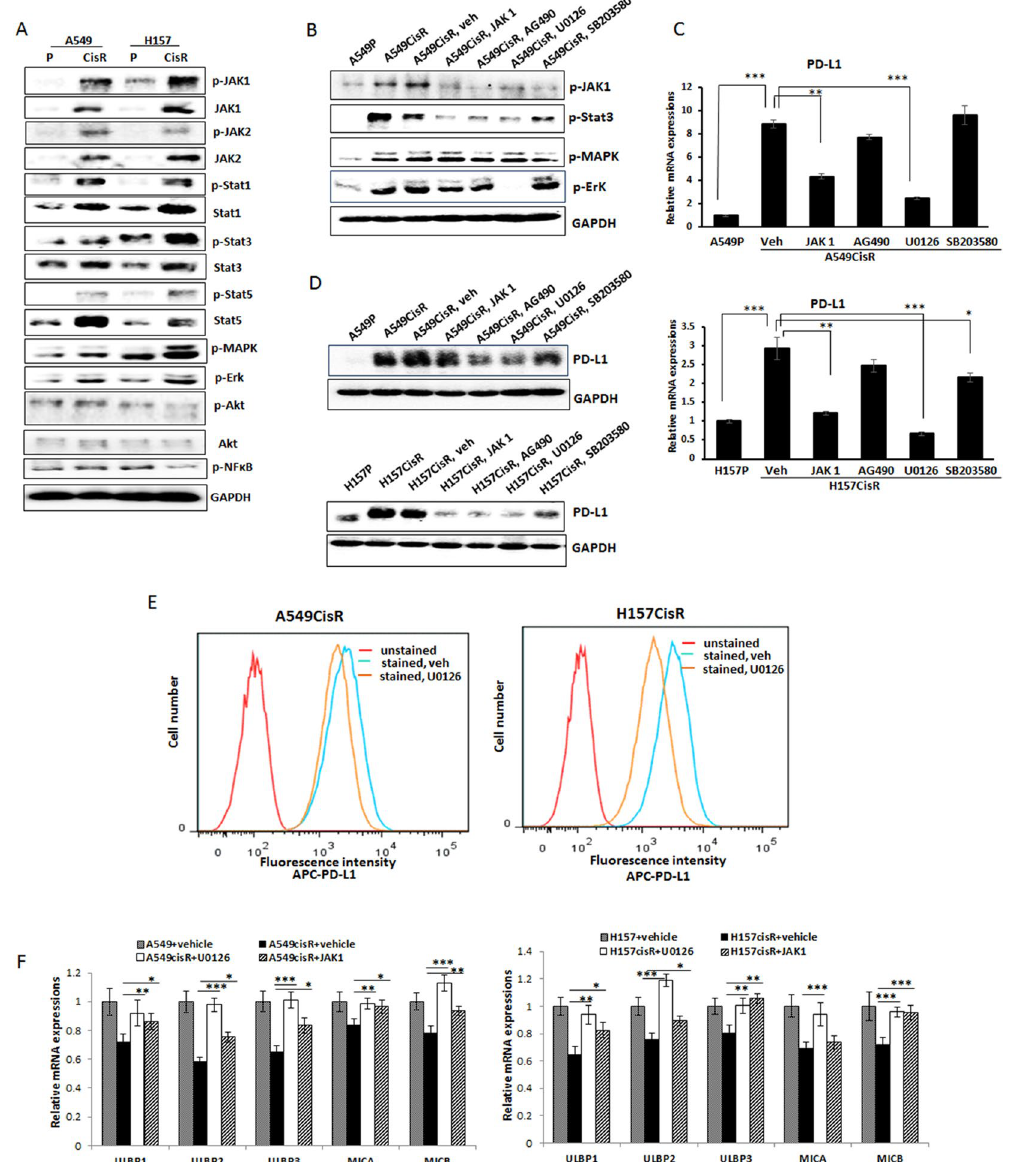
Figure 5. Effects of signaling pathway inhibition on PD-L1 levels in A549CisR and H157CisR cells. ( A ) Western blot analyses showing the expression/activation of several signaling molecules in parental and cisplatin-resistant cells. ( B ) Western blot analyses showing inhibition of each pathway in A549CisR cells upon inhibitor treatment. ( C , D ) PD-L1 levels in A549CisR and H157CisR cells upon treatment with inhibitors of indicated signaling pathways using qPCR analysis ( C ) and Western blot analysis ( D ). ( E ) Flow cytometric analyses of PD-L1 in cisplatin-resistant lung cancer cells. A549CisR and H157CisR cells were treated with U0126 (6 hours) (vehicle treated one as control) and positive stained APC-PD-L1 levels in these cells were analyzed. ( F ) NKG2D ligand expression on the A549CisR and H157CisR cells vs. parental cells. qPCR analyses show the recovery of NKG2D ligands upon addition of inhibitors of MEK/Erk and JAK signaling pathways. * p < 0.05, ** p < 0.01, *** p <